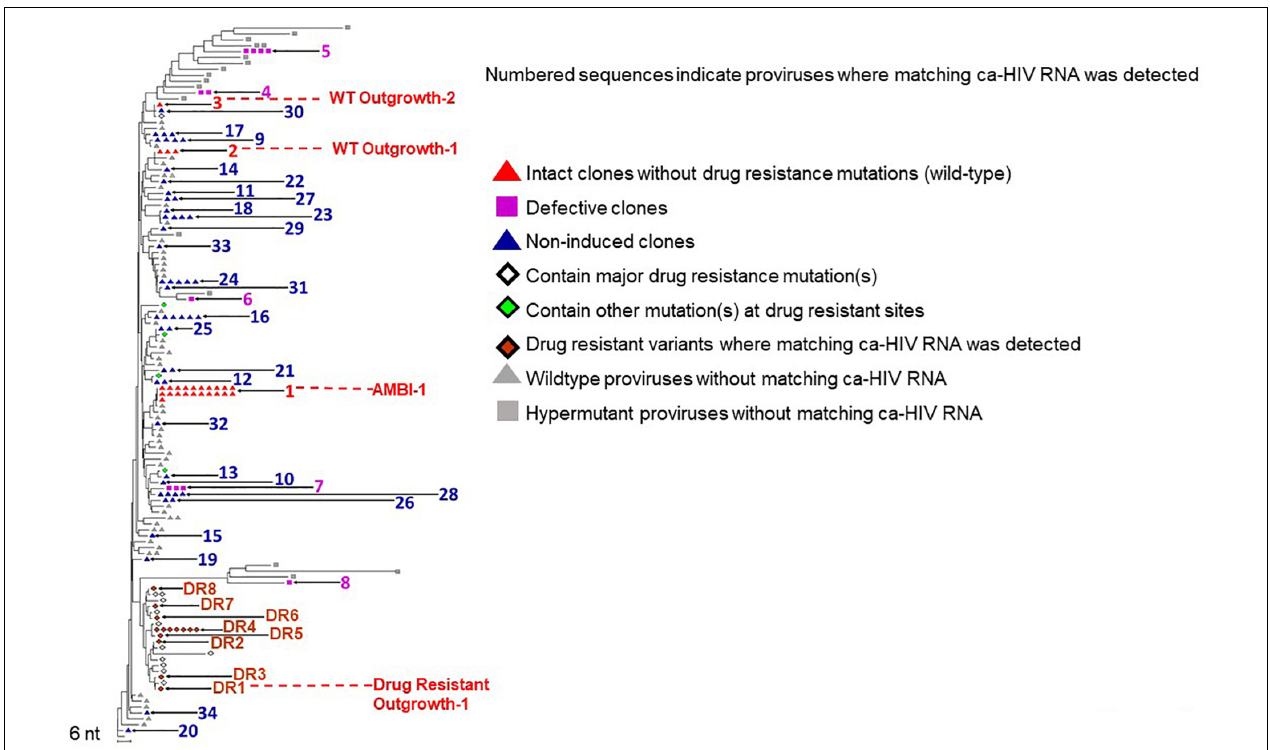
FIGURE 2 | NJ distance tree of PBMC viral DNA sequences from the timepoint indicated in red in Figure 1 . The tree contains possible clones with matching ca-HIV RNA (indicated with numbers) including the replication-competent clone AMBI-1, and the possible clones Outgrowth-1 and Outgrowth-2 in red, defective clones in purple, non-induced possible clones in blue, and DR proviruses with matching ca-HIV RNA in orange. Proviruses where no ca-HIV RNA was detected are shown in gray. A total of 183 proviral sequences were